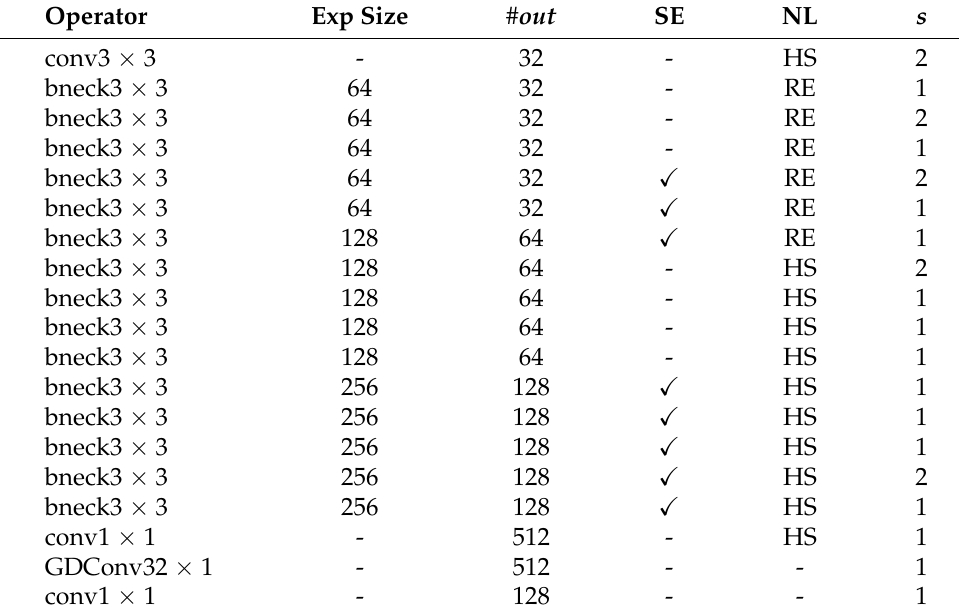
Table 1. Architecture of